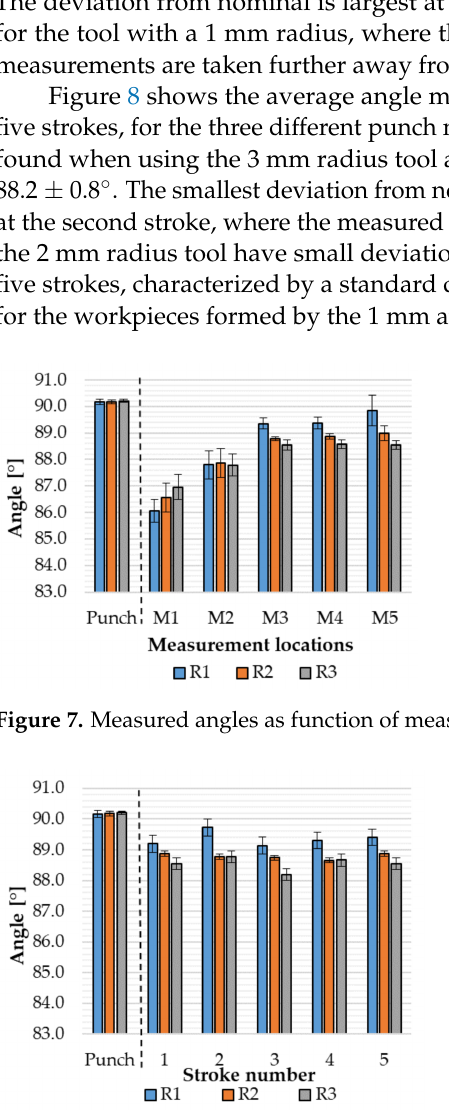
Figure 8. Measured angle at location M 3 as function of no. strokes performed for tools with different nose